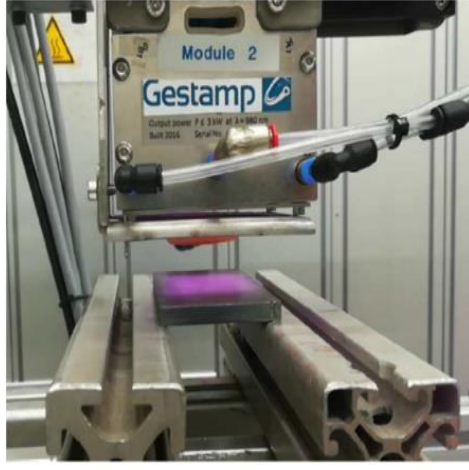
Figure 2. Heated blocks used for bainitic quench.